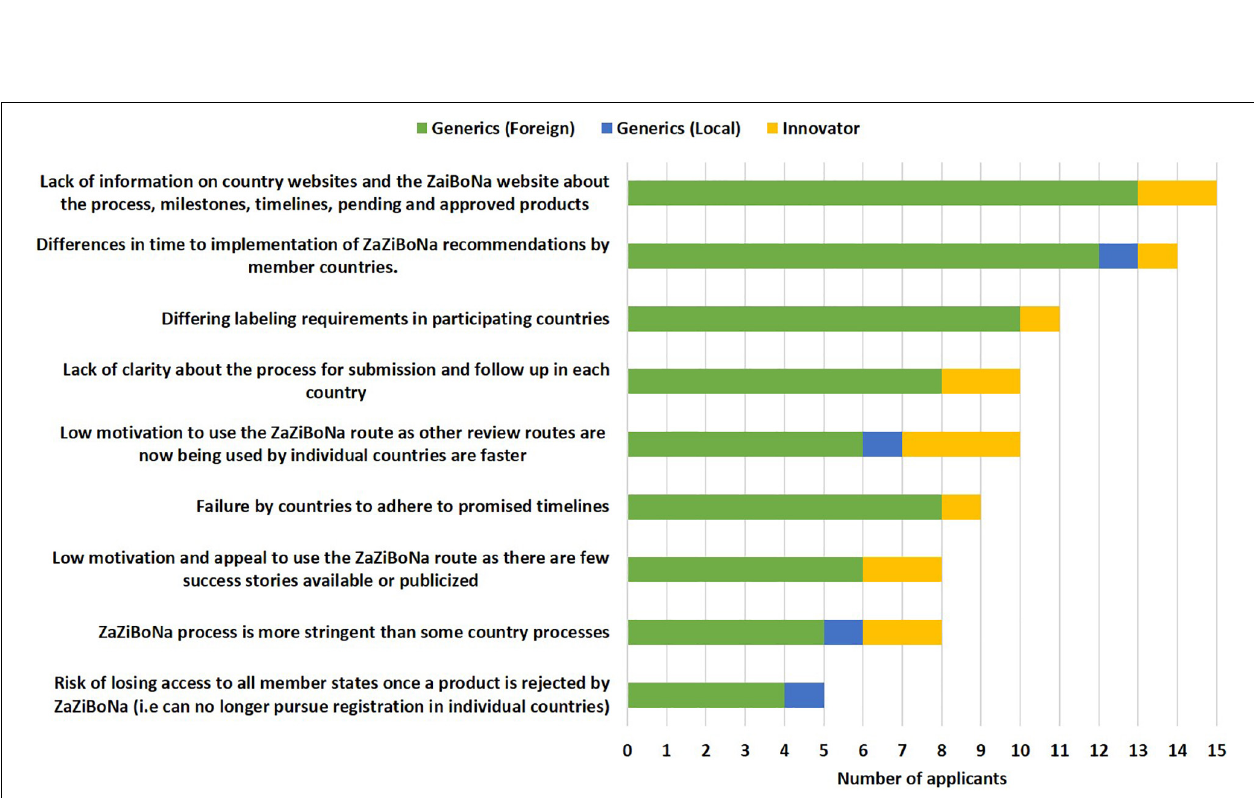
Frontiers in Medicine |